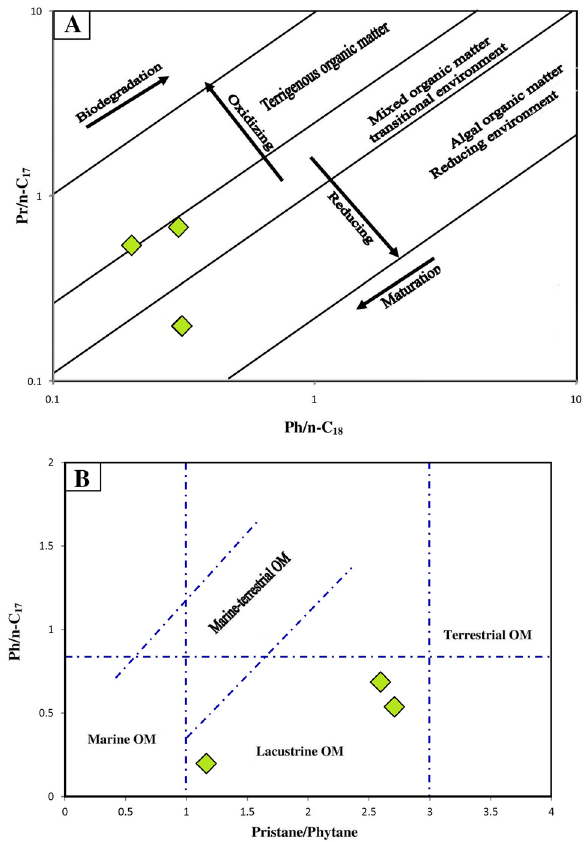
Fig. 7 Biomarker cross-plots of isoprenoid ratios: Pr/Ph, Pr/C17, and Ph/C18, show that the analyzed bituminite shale samples received a high contribution of algal organic matter and deposited in a lacus- trine environment under reducing conditions, ranging from suboxic to anoxic